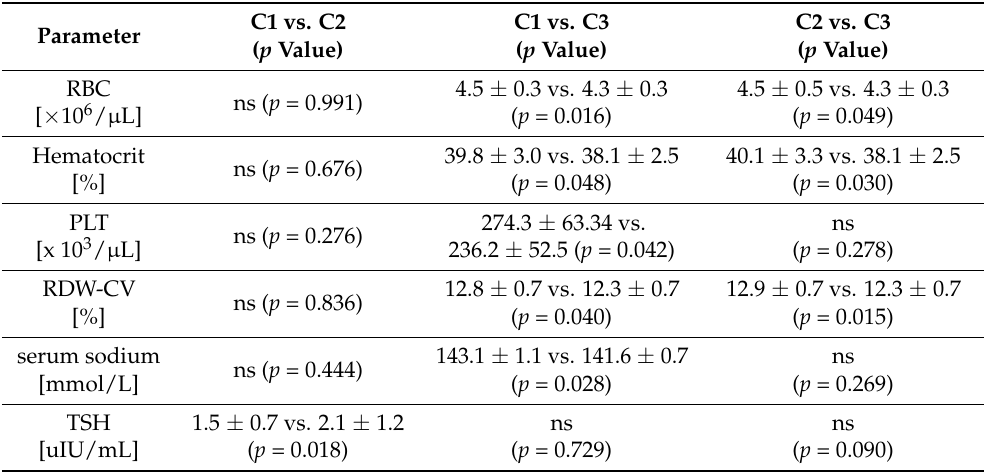
Table 2. Differences between the C1, C2 and C3 subgroups in selected peripheral blood and biochem- ical parameters (ns—not significant).